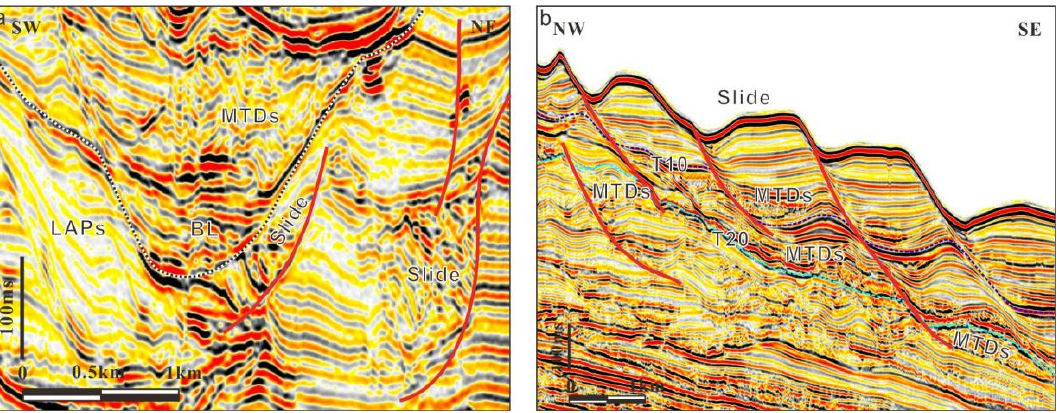
Figure 4. ( a ) Slides developed on margin of canyon and MTDs infilling the canyon; ( b ) slides developed on the canyon ridges.